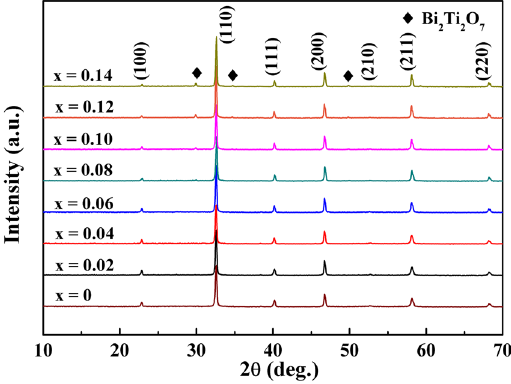
Figure 1. XRD patterns of the (1-x)LLBNTZ-xNBN